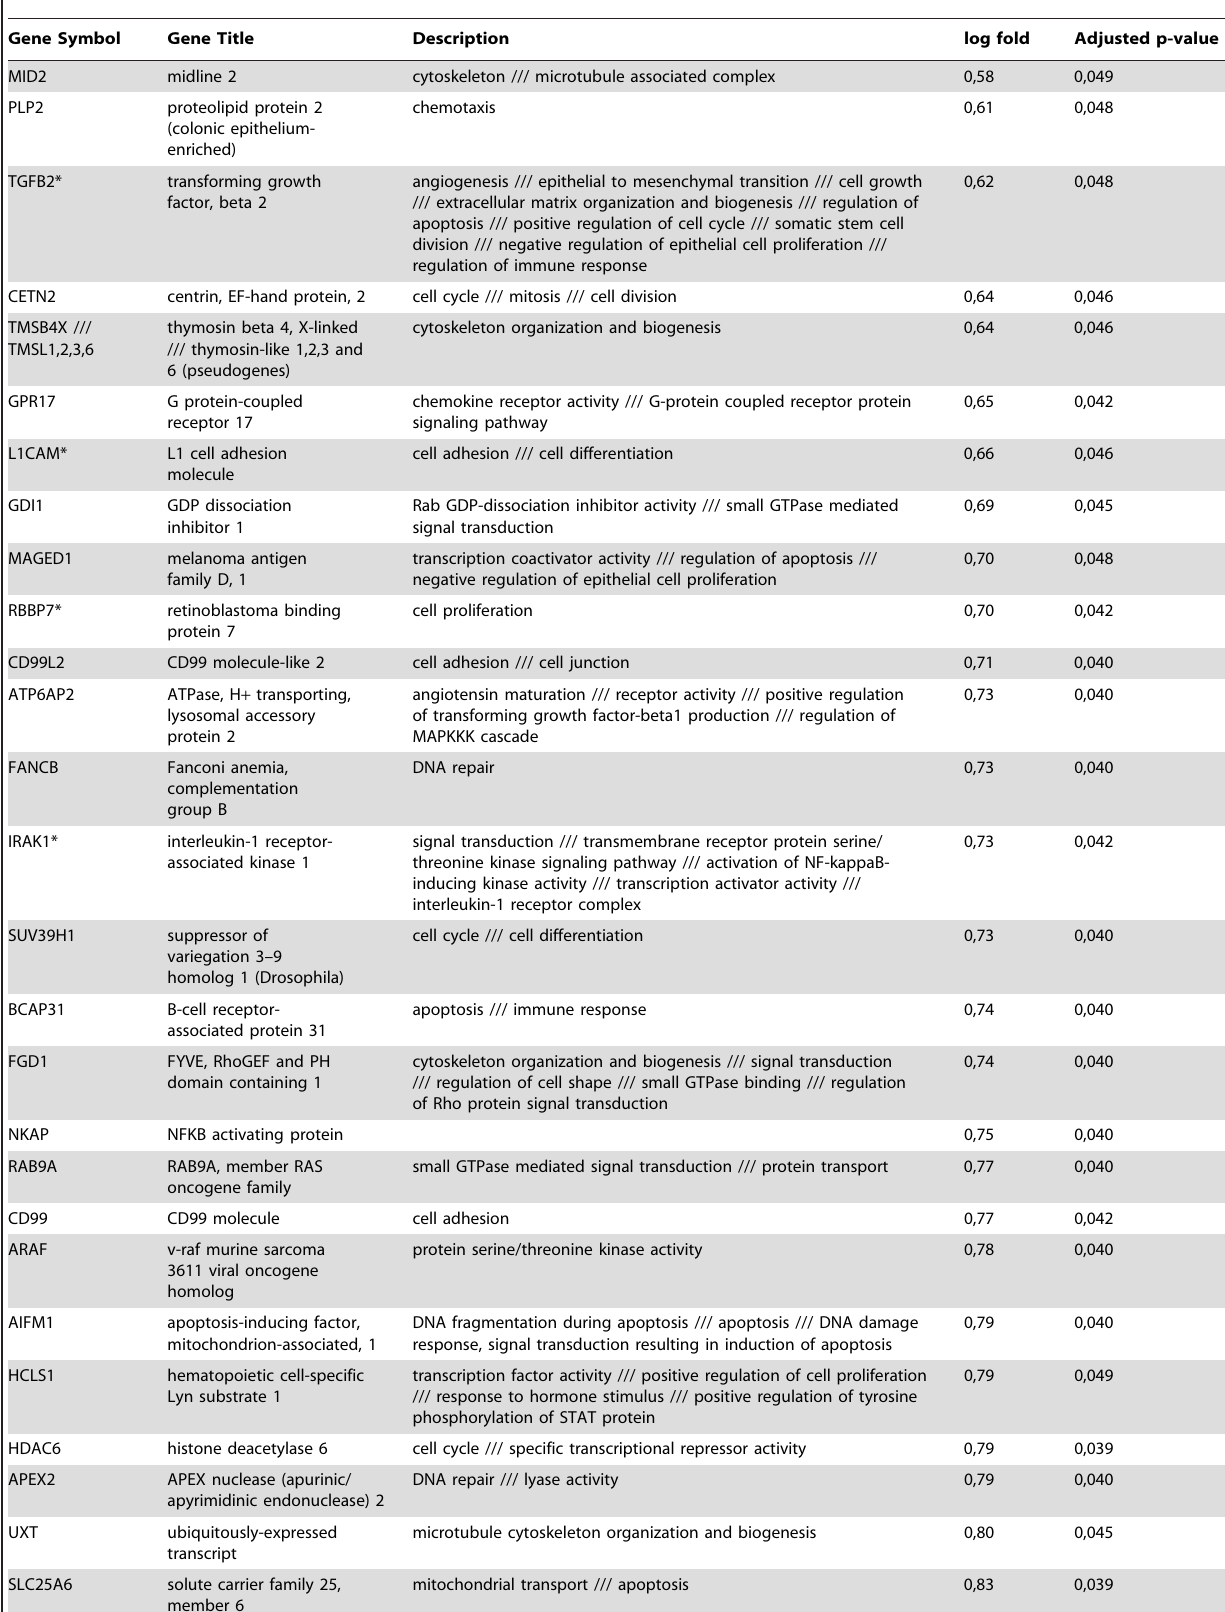
Table 2. List of genes that are up-regulated in INV cells versus REF cells.